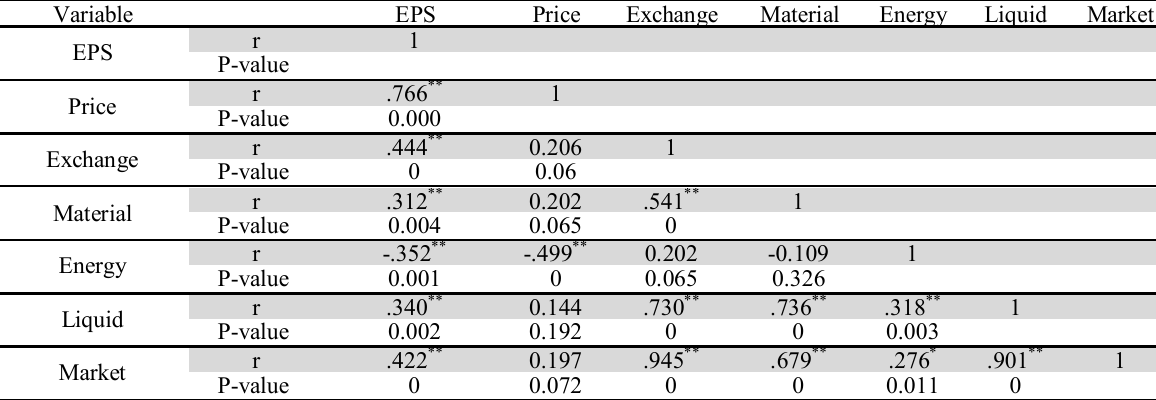
The summary of Pearson correlation